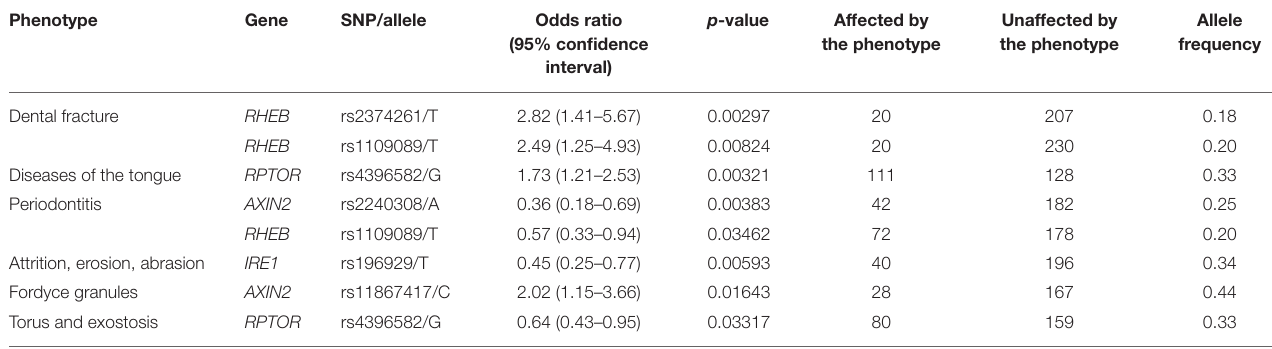
TABLE 4 | PheWAS summary results in the sample of Black